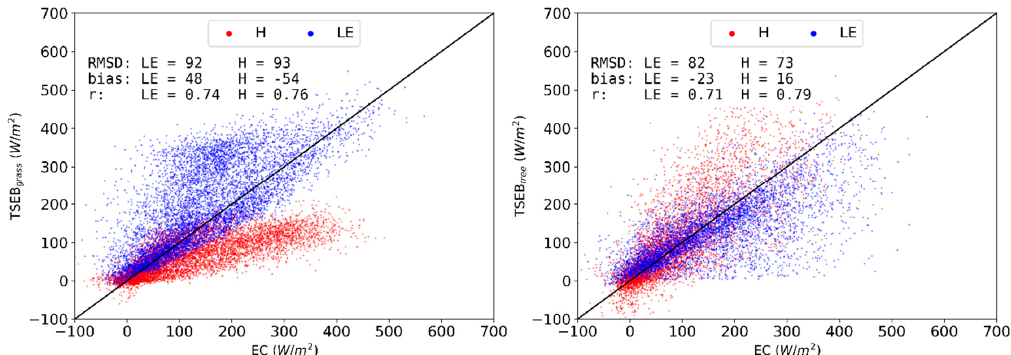
17 of 31 Figure 6. Observed vs modeled daytime half ‐ hourly H (red) and LE (blue) density scatterplot (left) and time series of simulated (red) and observed (black) daytime daily mean H (right) for TSEB ‐ DF in